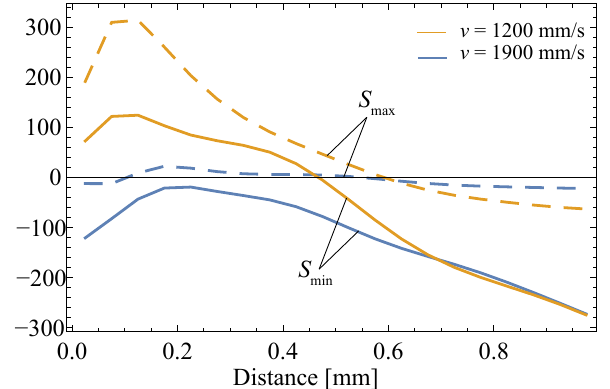
Figure 6. Experimental values of maximum and minimum residual stresses for two different laser velocities: v = 1200 mm/s and v = 1900 mm/s.